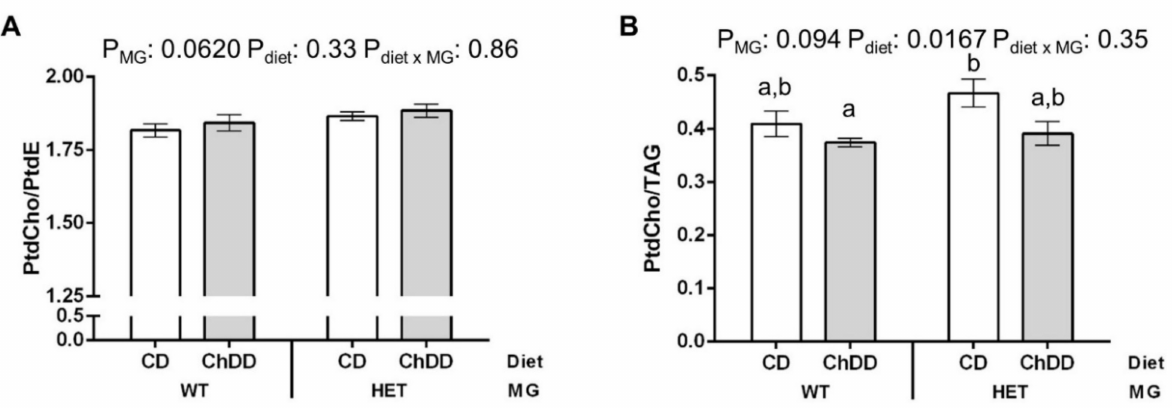
Figure 4. Effect of synthetase deficiency and low choline diet on PtdCho ratios in maternal liver. ( A ) Elevations in the PtdCho:PtdE ratio may indicate increased PtdCho synthesis by PEMT. ( B ) De- creases in the PtdCho:TAG ratio have been linked to decreased PtdCho synthesis via the CDP-choline pathway. Values are means ± SEM, n = 6 per group. Analysed by 2-way ANOVA; means without a common letter differ significantly by Tukey post hoc ( p < 0.05). White bars: CD, grey bars: ChDD.